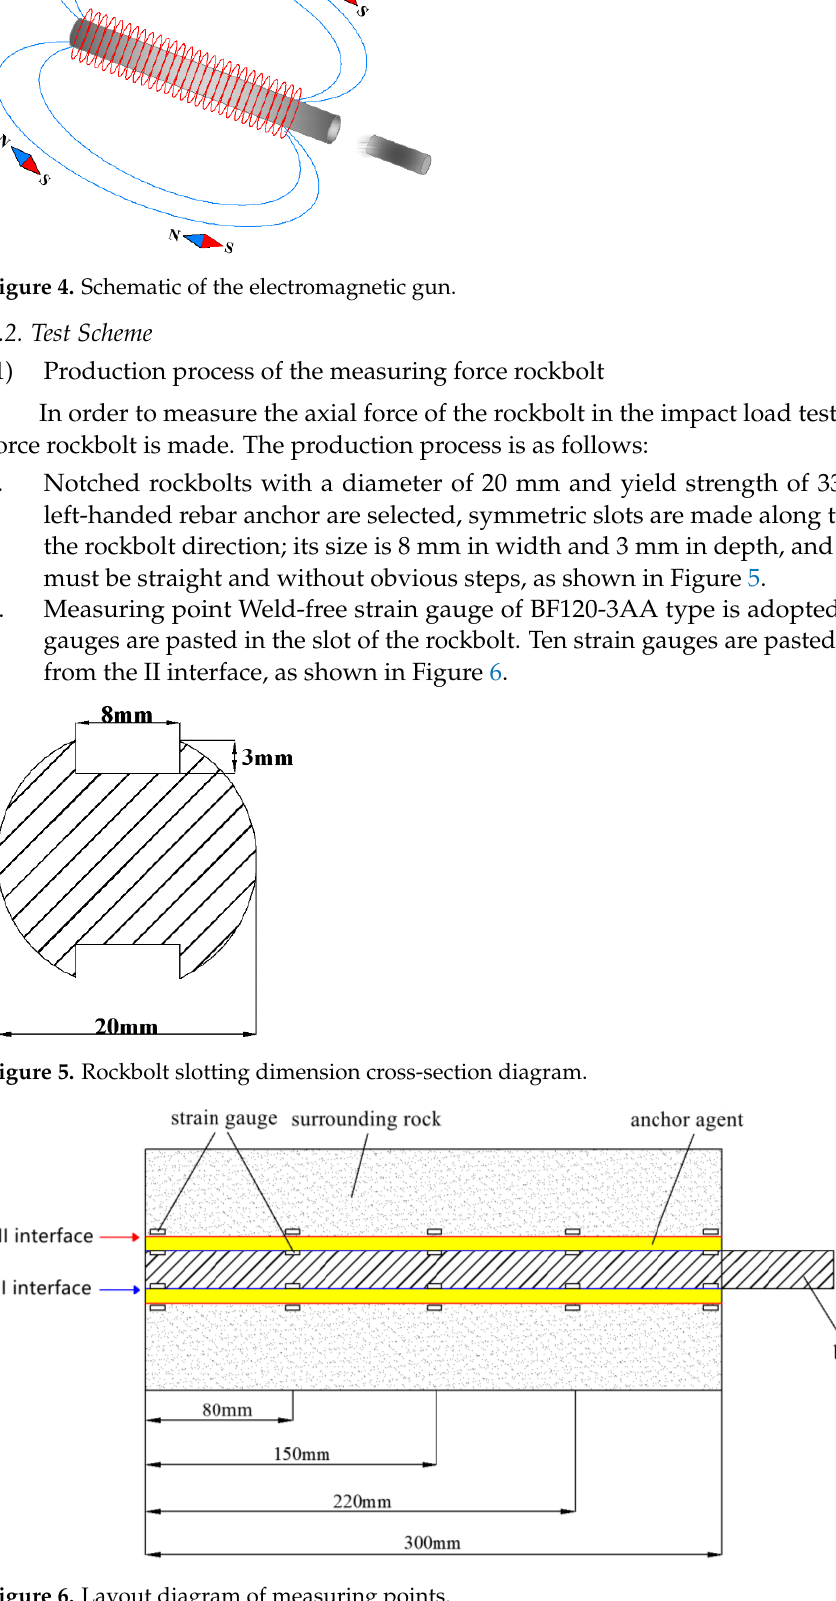
( f ) Figure 7. Transparent anchoring structure surrounding rock production process. ( a ) Putting trans- parent glue block ( b ) Casting transparent solution ( c ) Pasting the first layer strain gauge ( d ) Re- served holes ( e ) Pasting the second layer strain gauge ( f ) End of specimen production.